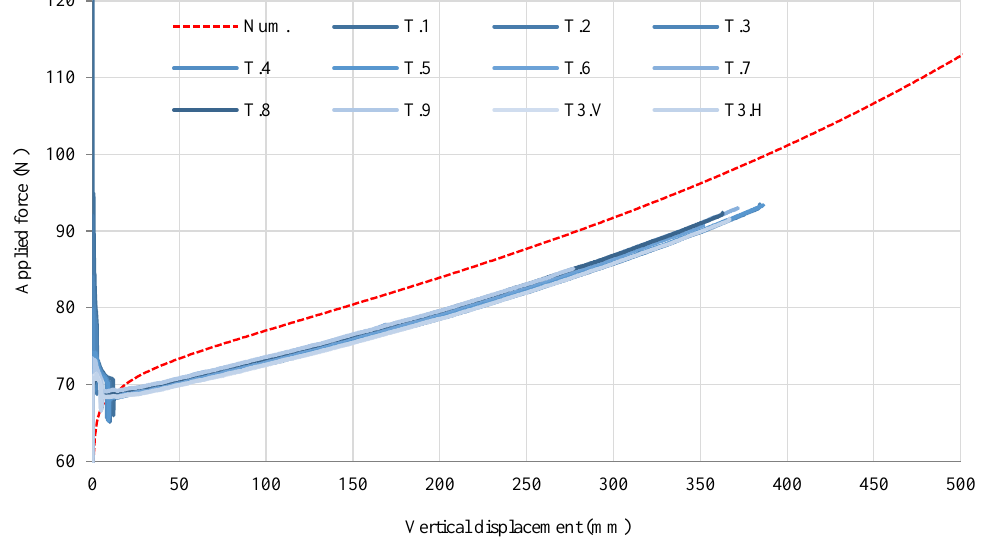
Fig. 11 Applied force vs. vertical displacement, comparison of experimental (T) and numerical (Num) results. In terms of axial stresses, strains were experimentally measured with a strain gauge at the centre of the glass plates, and then converted to stress by applying the Hooke’s Law, considering E=74.0 GPa. As presented in Fig. 12, the numerical behaviour was similar to the experimental data. The results obtained show also that the ratio between numerical and experimental stresses is around 1.35 for lower load levels and then progressively tends to around